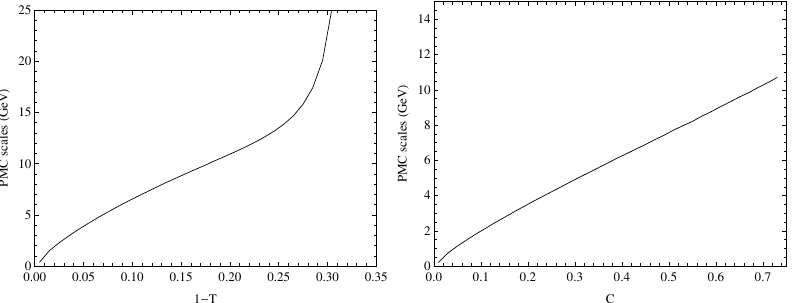
Figure 2. The PMC scales for the event shape observables thrust ( T ) and C -parameter ( C ) at √ s = 91.2